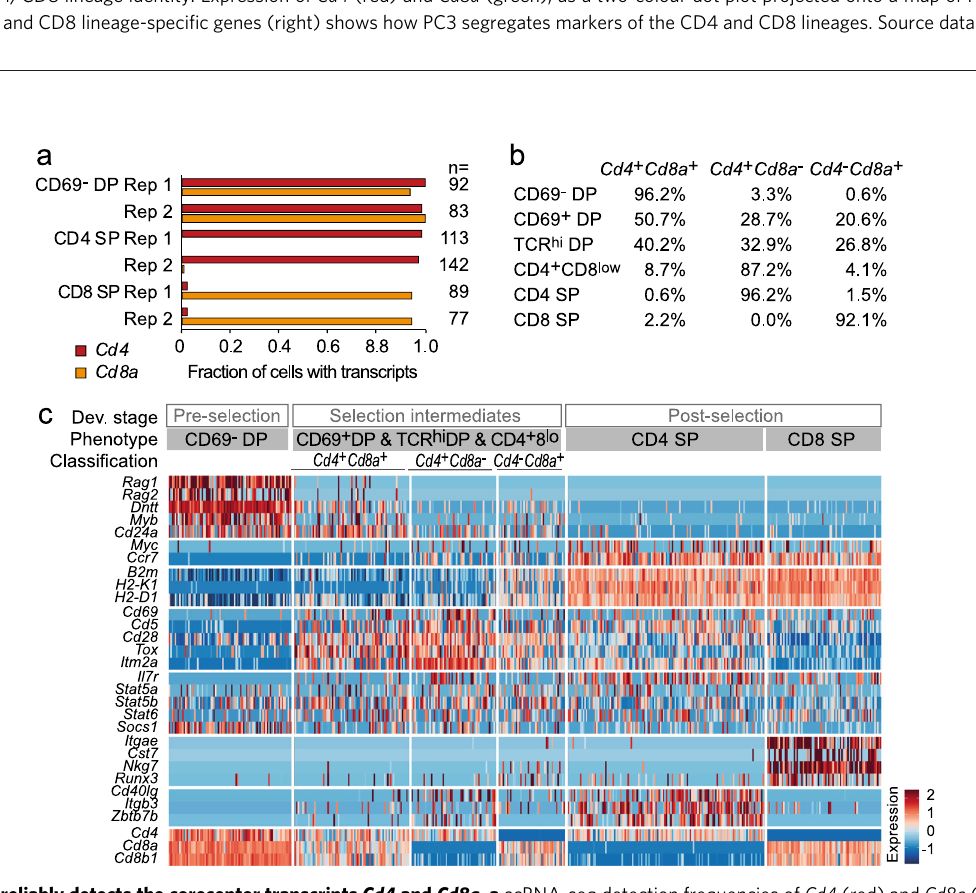
Fig. 1 scRNA-seq captures maturation, activation and lineage identity as principal components of CD4/CD8 lineage choice and differentiation. a Highly variable genes in the scRNA-seq data were identi fi ed and principal component analysis (PCA) was performed, excluding Cd4, Cd8a and Cd8b1 . PC1 versus PC2 (left) and PC1 versus PC3 (right) are shown, and the percentage of variance explained by each PC is indicated as a percentage of the fi rst fi ve PCs. PC4 and PC5 explained 11.45% and 8.50% of variance within the fi rst fi ve PCs and 5.82% and 4.32% of total variance, respectively. Sorted subsets are coloured as indicated in the key. Cell numbers are shown in Supplementary Table 2. Source data are provided as a Source Data fi le. b PC1 re fl ects progressive thymocyte maturation. A two-colour dot plot projected onto a map of PC1 versus PC2 shows expression of Rag1 (red), which was con fi ned to pre-selection thymocytes, and Ccr7 , which was acquired during maturation. A heat map of key thymocyte maturation genes (right) shows how markers of immature thymocytes are progressively lost along PC1 and markers of mature thymocytes are progressively gained along PC1. Source data are provided as a Source Data fi le. c PC2 re fl ects transient thymocyte activation. Expression of the activation marker Cd69 (green) projected onto a map of PC1 versus PC2. Heat maps of key thymocyte activation genes (right) show how markers of thymocyte activation are progressively gained along PC2. The same markers show non-linear behaviour along PC1, as they are fi rst gained and then lost during thymocyte maturation. Source data are provided as a Source Data fi le. d PC3 re fl ects CD4/CD8 lineage identity. Expression of Cd4 (red) and Cd8a (green), as a two-colour dot plot projected onto a map of PC1 versus PC3. A heat map of CD4- and CD8 lineage-speci fi c genes (right) shows how PC3 segregates markers of the CD4 and CD8 lineages. Source data are provided as a